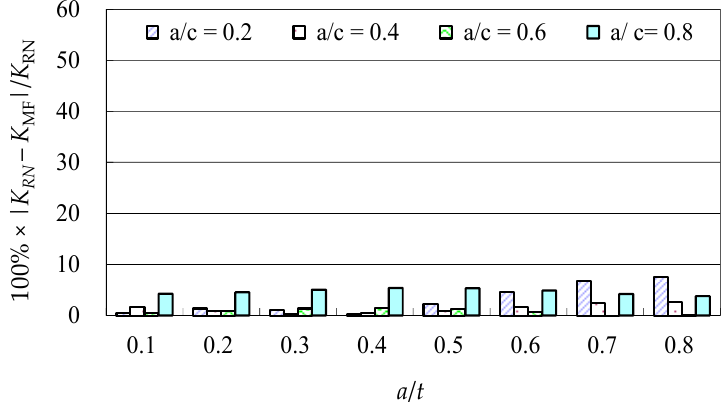
Figure 15. Modified formula vs. the Raju-Newman solution at point B ( c / W = 0.1).